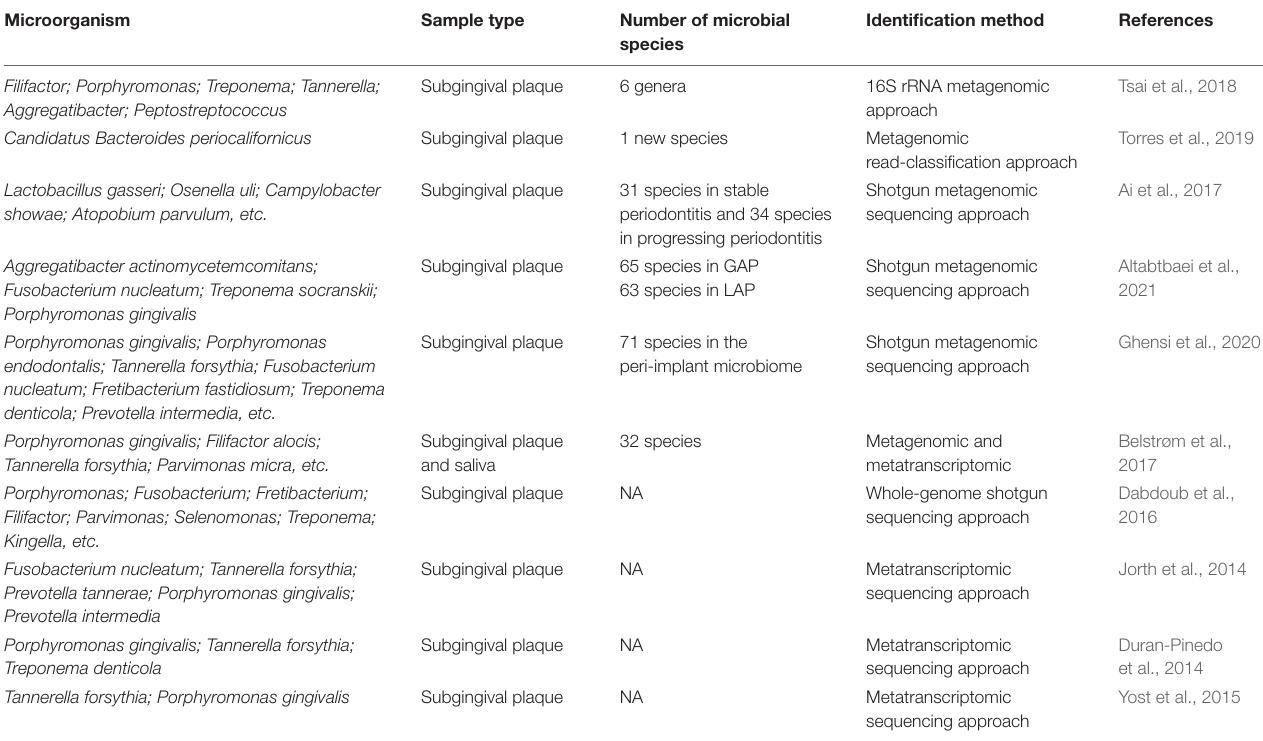
TABLE 1 | Profiling periodontitis related pathogens with metagenomics and